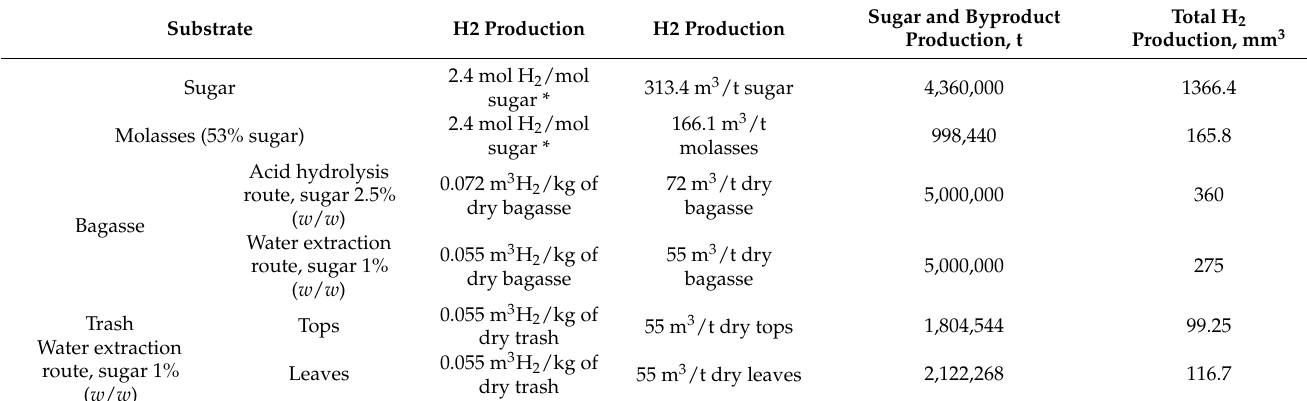
Table 20. Potential of production of hydrogen from sugar, molasses, bagasse and trash [36,38].